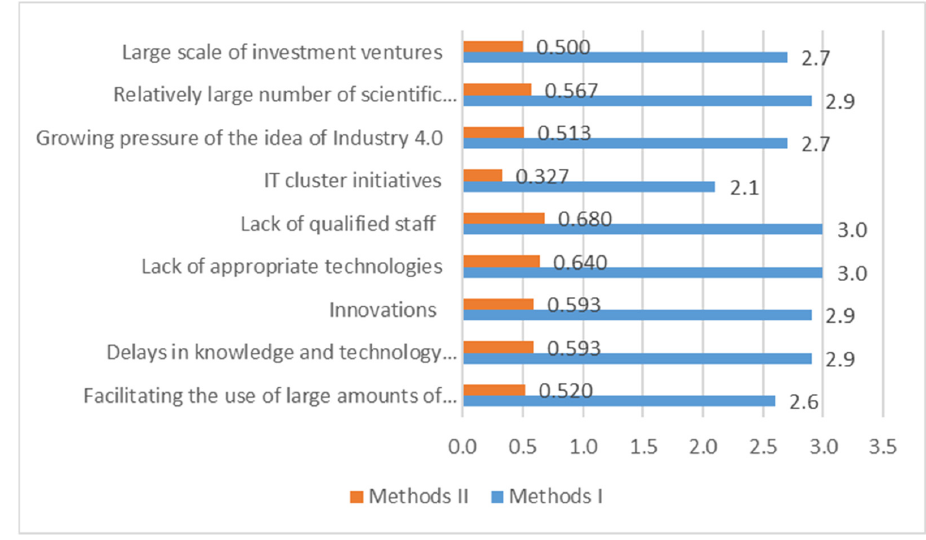
Figure 10. Comparison of the results for technological factors with both methods. Authors’ own study.